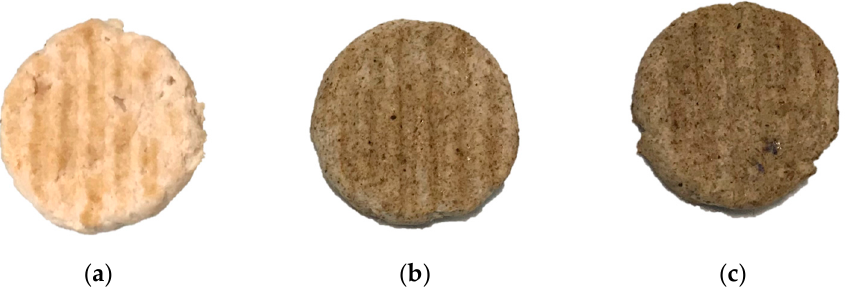
Figure 1. Uncooked burgers of the three experimental batches: ( a ) control (CTRL) without CSS additions; ( b ) with addition of +1.5% of coffee silver skin (CSS 1.5%); ( c ) with +3.0% of coffee silver skin (CSS 3.0%).